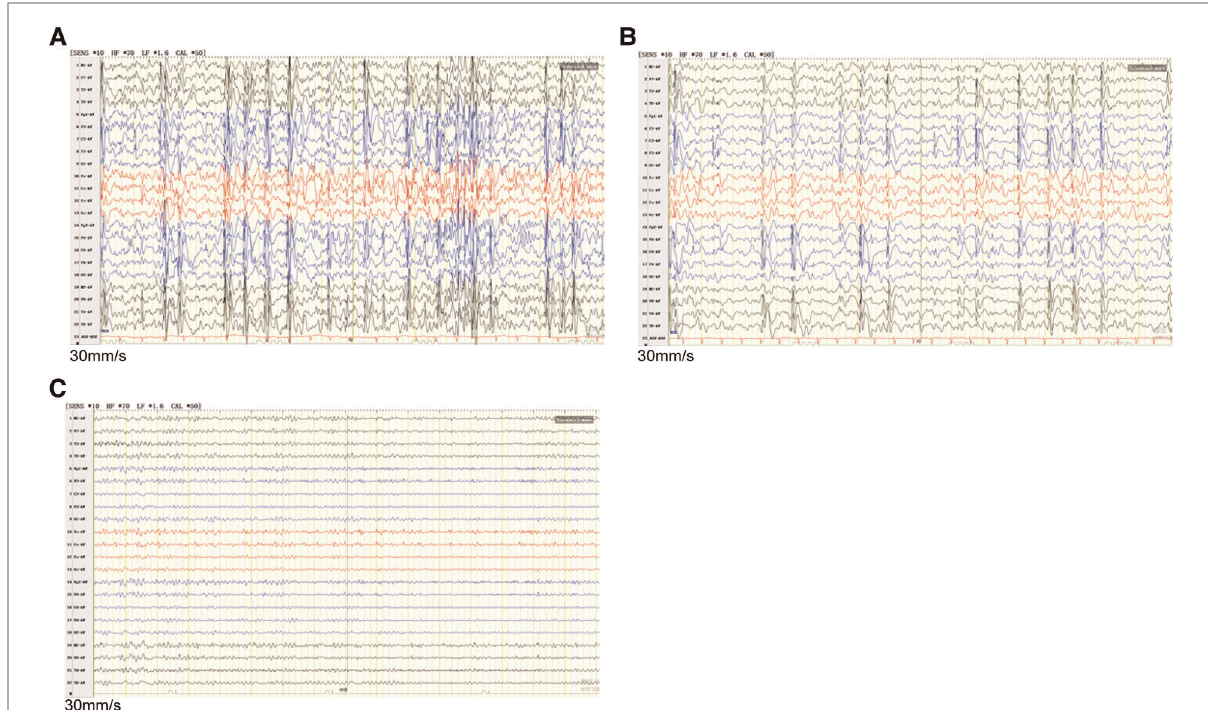
FIGURE 1 EEG discharges in the proband and his mother. ( A ) Interictal EEG recorded of the proband during waking showed generalized spike-slow wave complexes. ( B ) The interictal EEG of the proband during sleep showed runs of spike-slow wave complexes arising from bilateral temporal regions. ( C ) The mother ’ s EEG showed epileptiform discharges in the midline area. EEG,